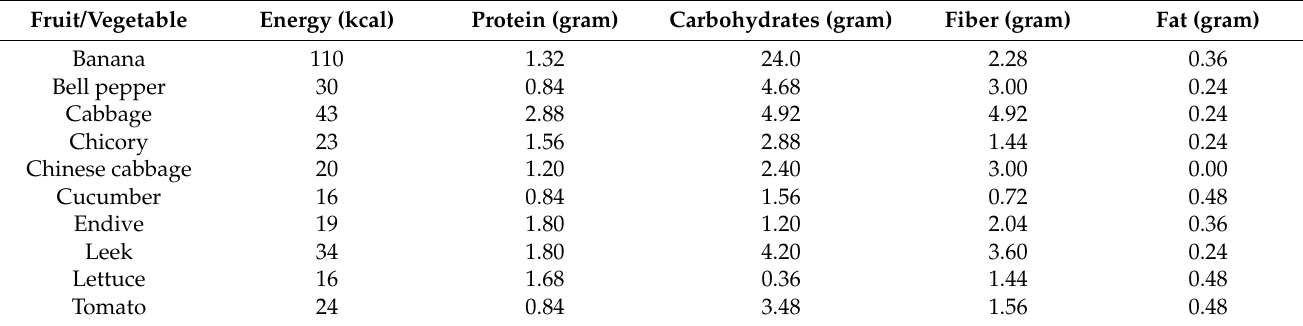
Table A1. Nutritional values of the 10 most commonly fed fruit and vegetables at BPRC (in alphabetical order) based on the amount fed per adult: 120 g. Source: The Dutch Food Composition Database (NEVO, online version 2019/6.0).